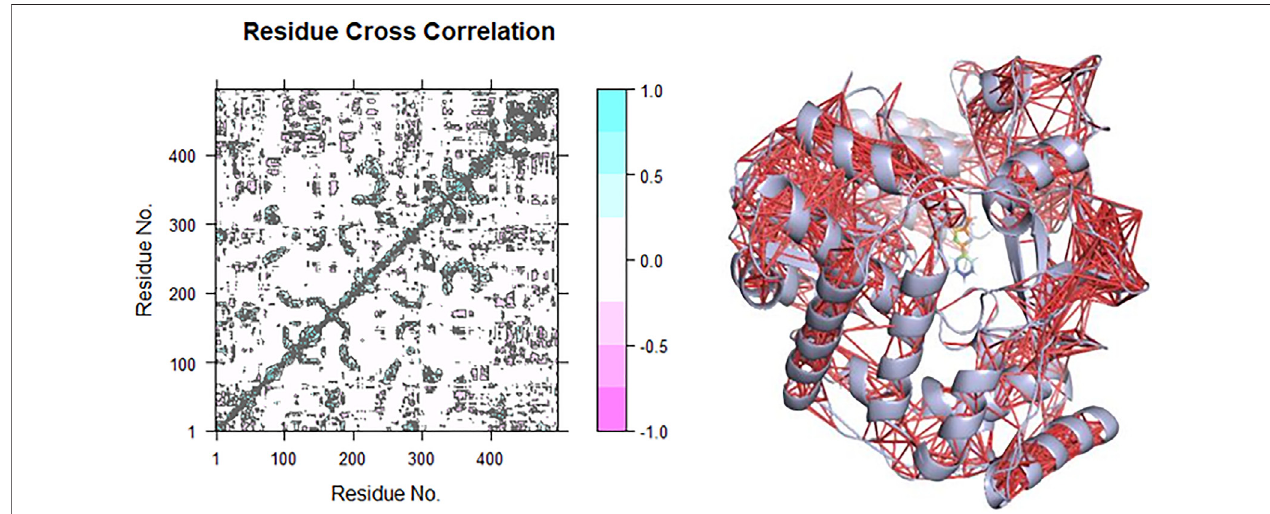
FIGURE 8 | Correlation (red lines) in the residues of the receptors during the MD simulation was obtained using the DCCM method for CHEMBL1204385 interaction with HuNoV RdRp.